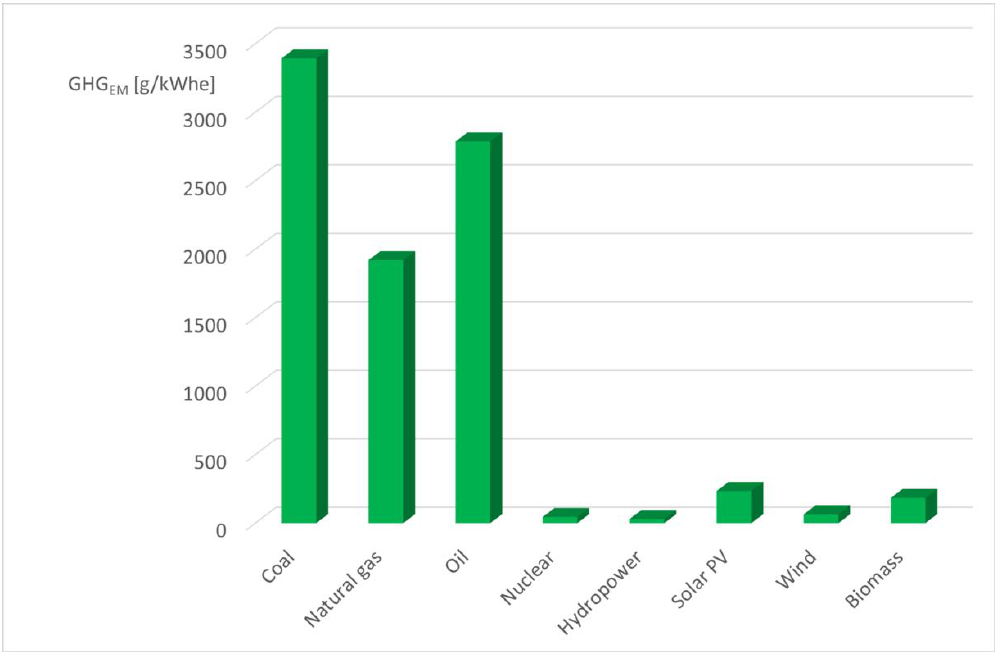
Figure 12. GHG emissions for the electricity production for different sources.